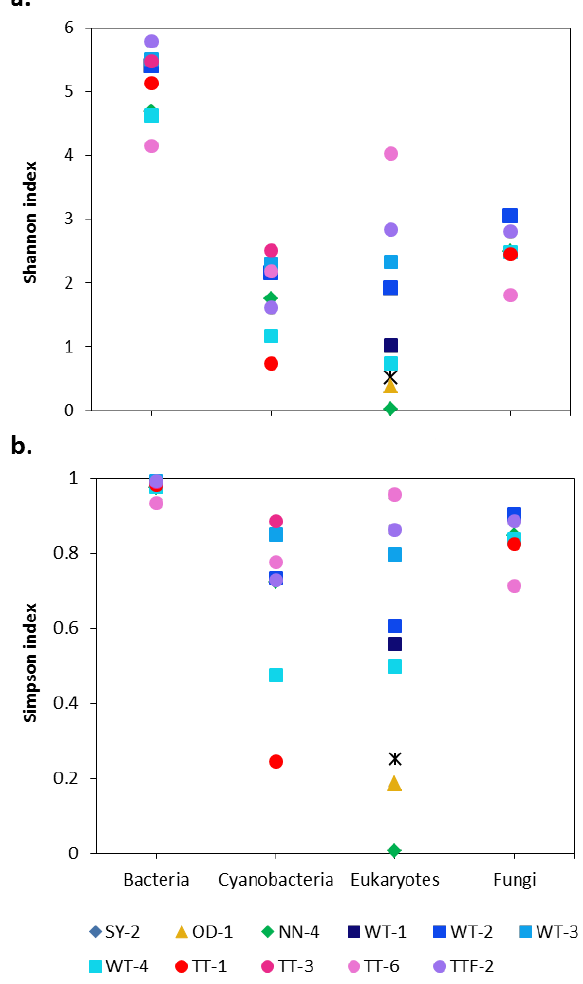
Figure 1. Alpha diversity indices in the studied biocrusts: ( a ) Shannon and ( b ) Simpson. SY, OD, WT, TT and NN correspond to Shreyahn, Oedesse, Wietze, Teutschenthal and the not named site, respectively.